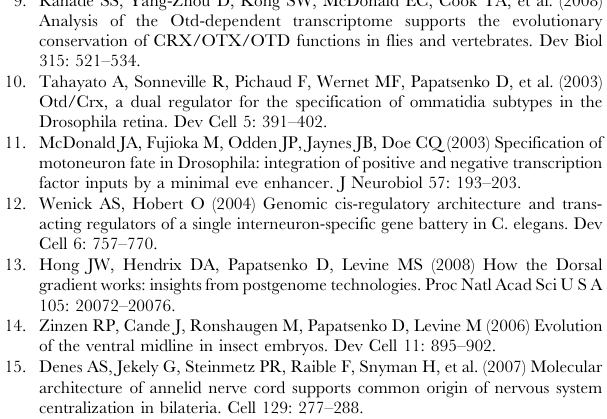
Figure S3 Motif-tissue scores of the 2 6 GATTA cis -regulatory signature depending on window size. Window size between two